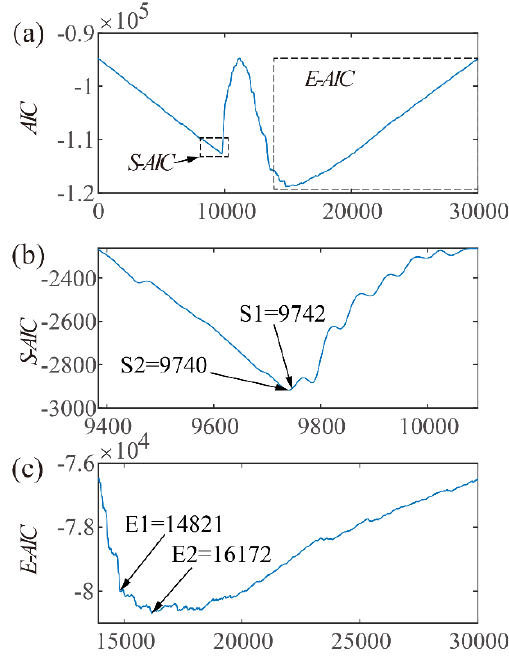
Figure 10. The AIC time series of the entire, front and rear time window, respectively. ( a ) The AIC of the entire waveform; ( b ) The AIC of the front time window segment; ( c ) The AIC of the rear time window segment. S-AIC and E-AIC are the recalculation results of the two dashed boxes in ( a